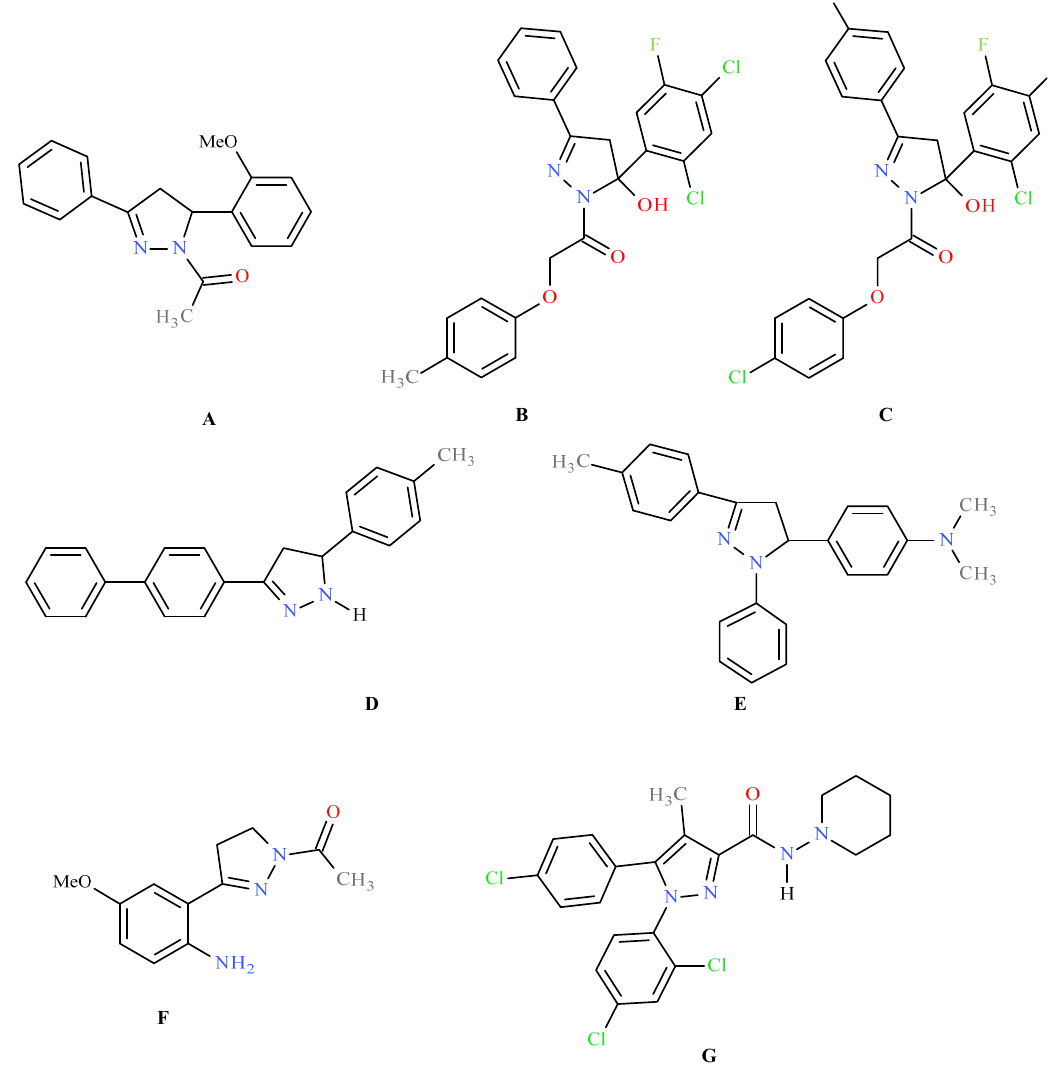
Figure 1. Examples of pyrazoline analogs with biological activity: ( A )–anticancer, ( B )–antibacterial, ( C )–antifungal, ( D )–anti-inflammatory, ( E )–antidepressant, ( F )—nitric oxide synthase (NOS) inhibitor and ( G )—cannabinoid CB1 receptor